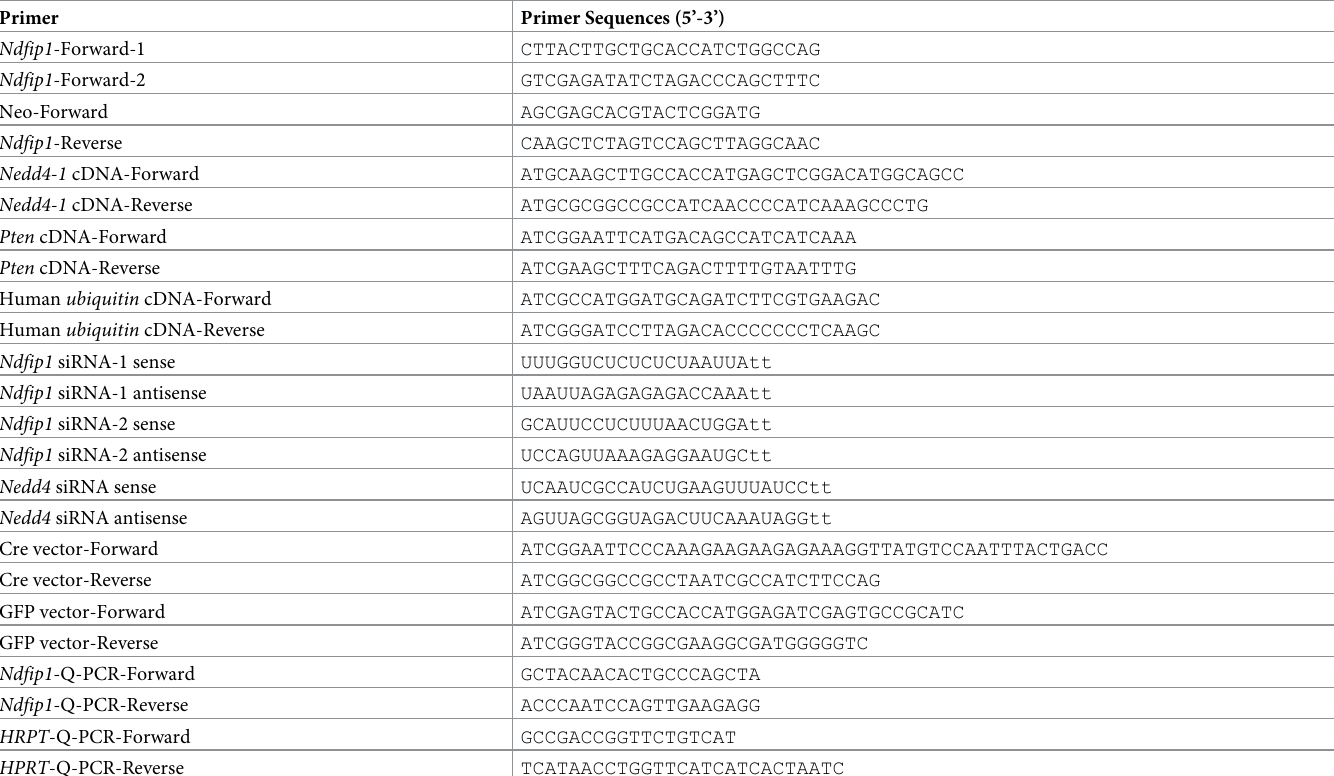
Table 1. List of all the primers